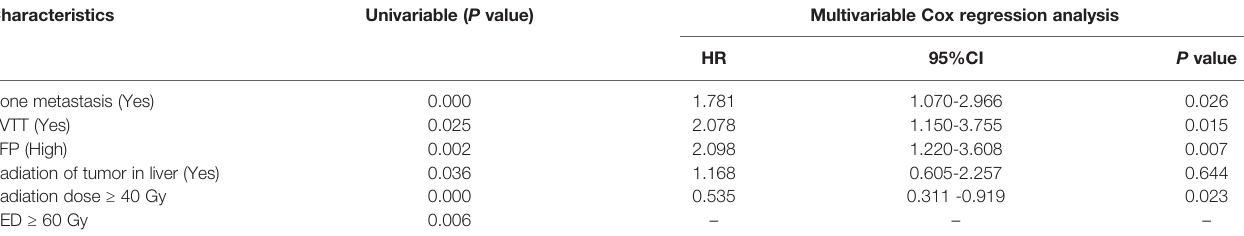
TABLE 2 | Univariable and multivariable Cox regression analysis.